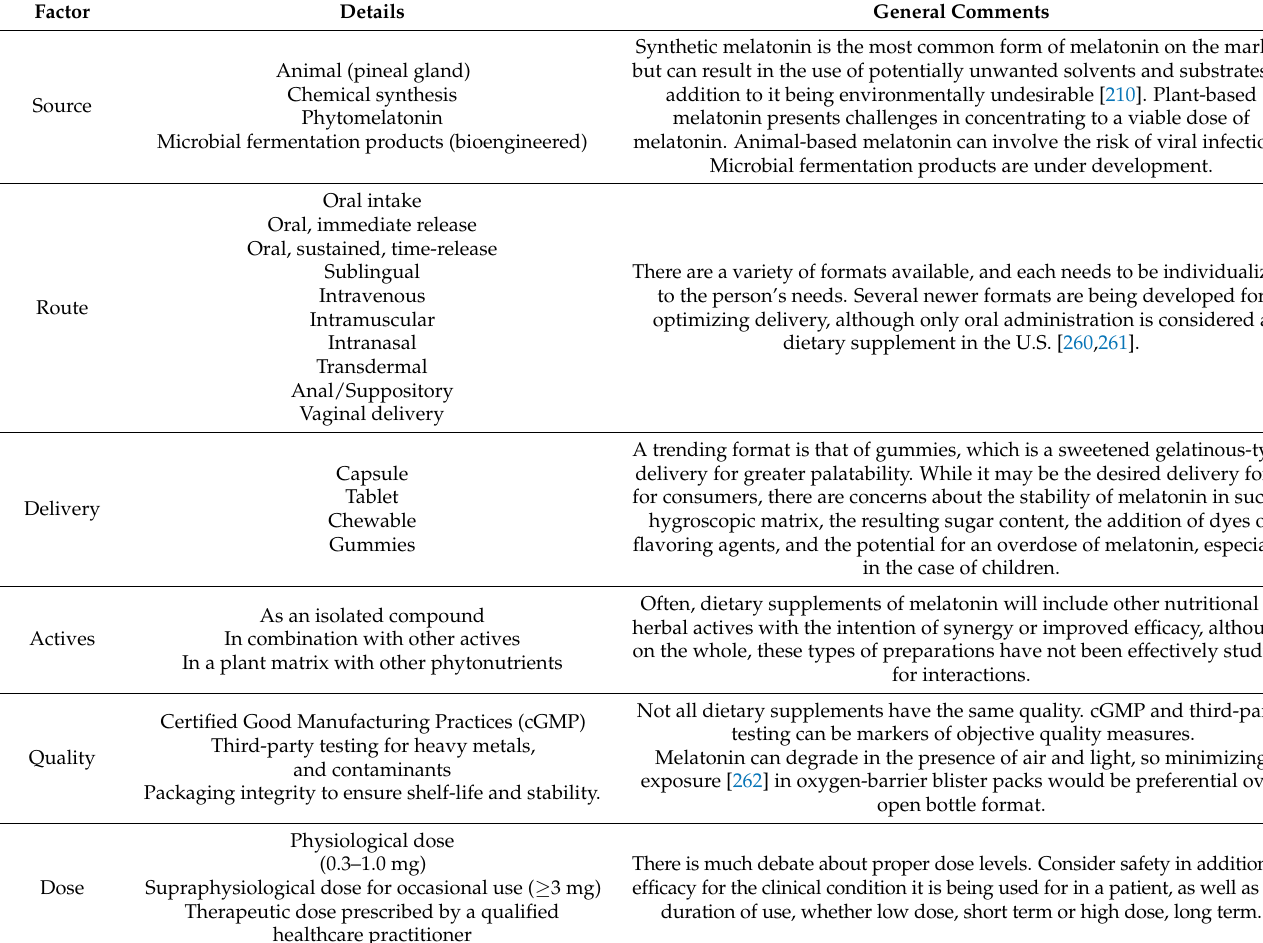
Table 4. Considerations in the selection of a melatonin